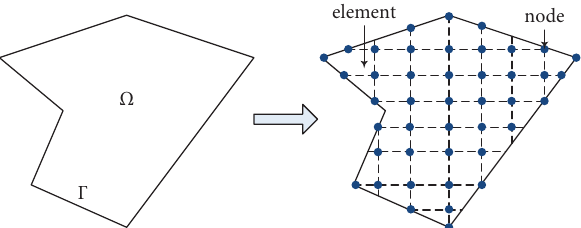
Figure 1: The initial room is divided into a set of subdomains. The wave model is numerically built based on these